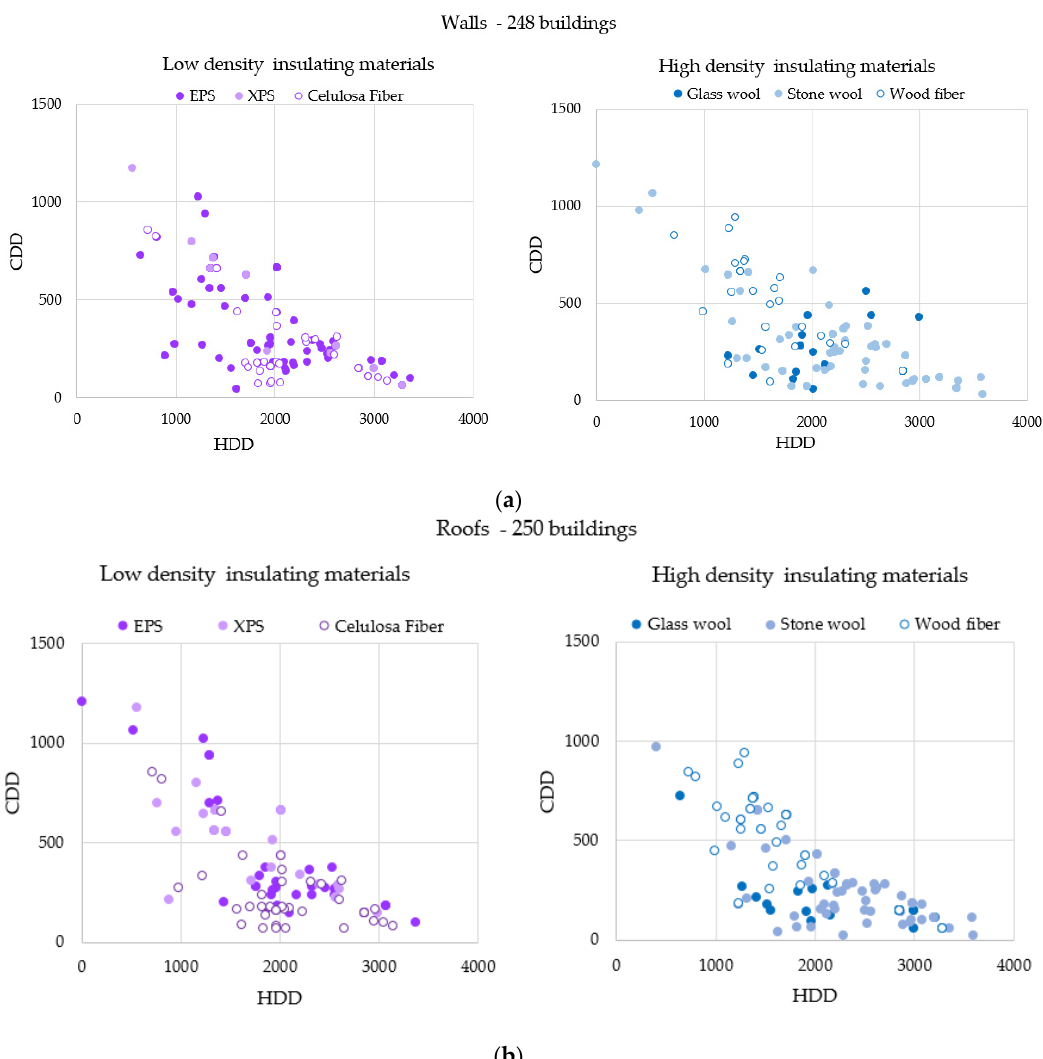
Figure 10. Typology of the most common insulating material used in the walls ( a ) and in the roofs ( b ) of noted data nZEBs collected, in relation to the HDD and CDD and according to low and high density of insulating materials.